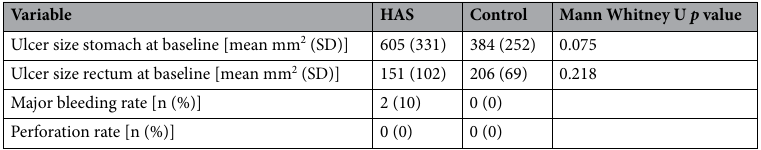
Table 2. Details of endoscopic procedures. Mann–Whitney U test was used for statistical analyses. HSA Hemospray application, SD standard deviation.